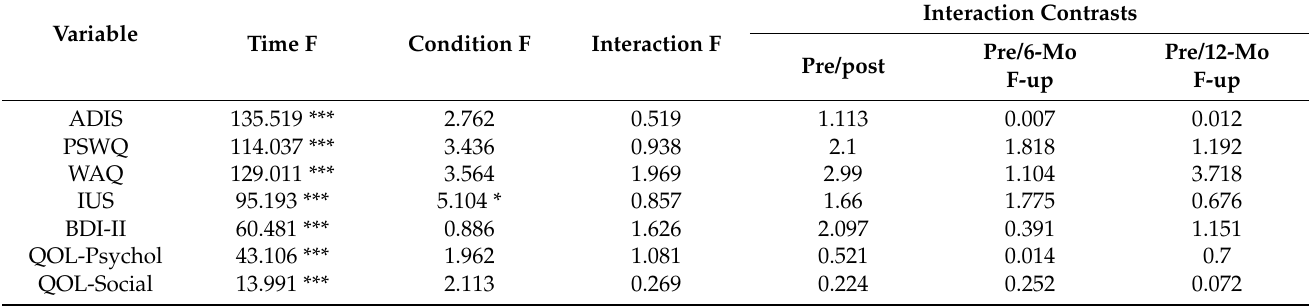
Table A1. Results of multilevel linear modeling analyses for a randomized control non-inferiority trial comparing the delivery of psychotherapy by videoconference or face-to-face to adults with generalized anxiety disorder ( n = 148).